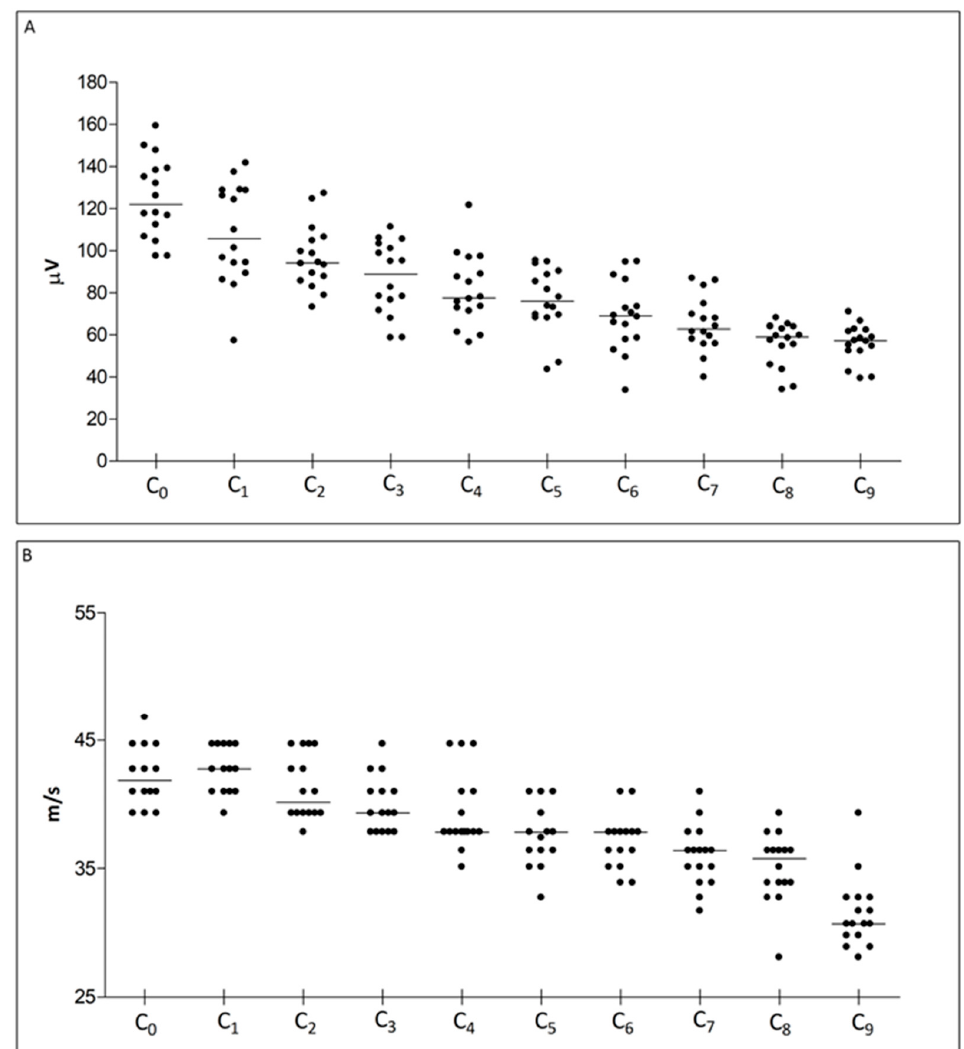
Figure 1. Distribution of NCS parameters at baseline, showing values at each site for the whole studies population. In ( A ) sensory nerve action potential (SNAP) amplitude data is shown, and in ( B ) sensory conduction velocity (SCV) data. Recordings were obtained following the montage described in methods section (C 0 was obtained at the base of the tail and then the montage was placed distally in the adjacent segment C 1 , and subsequently recordings were repeated for the whole length of the tail up to the tip).